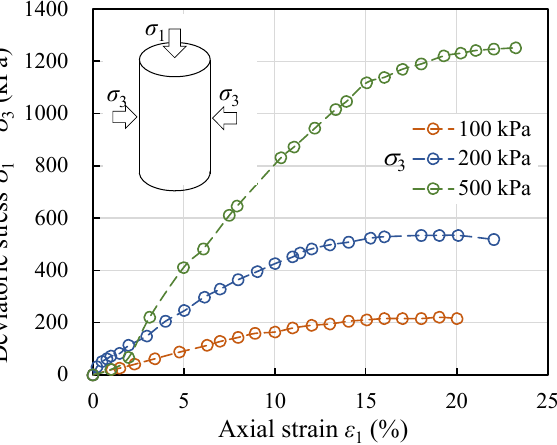
Figure 7. Physical model and deviatoric stress–strain curve under different confining pressures of consolidated drained compression triaxial tests on Cannington paste backfill, with a cement content of 2% and a curing time of 28 days performed by Rankine [28].